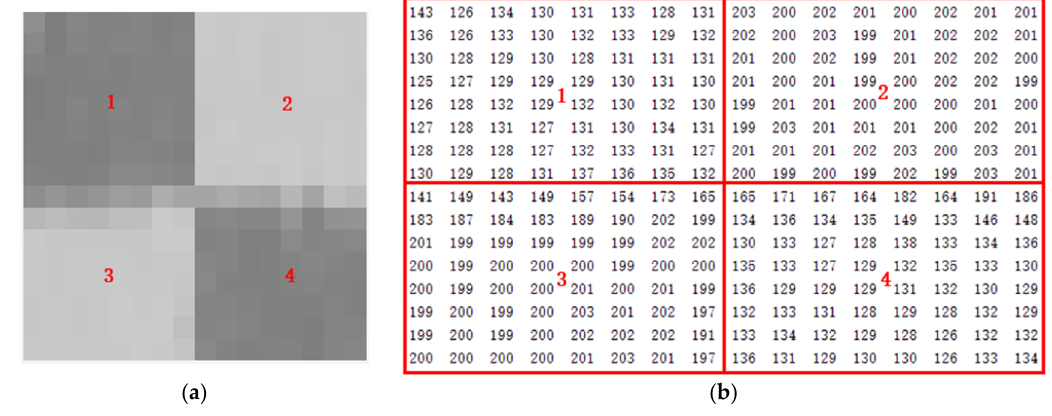
Figure 11. ( a ) Target in grayscale image; ( b ) Target pixel value distribution.